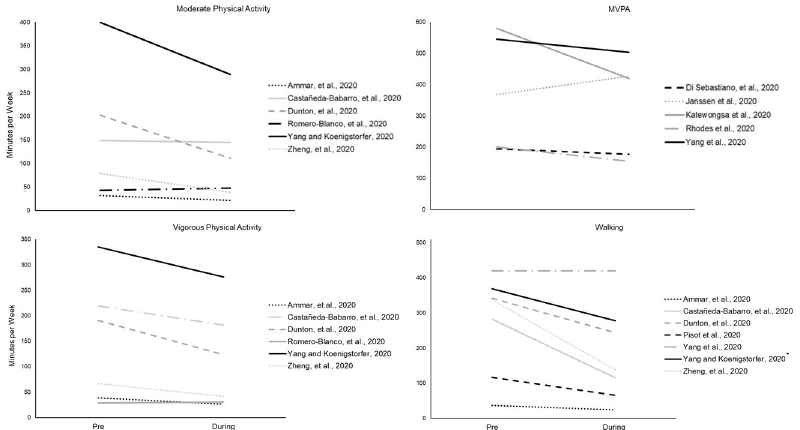
Fig 3. Change in moderate, vigorous, MVPA, and walking behaviour from pre- to during COVID-19. Asterisk indicates non-significant difference.